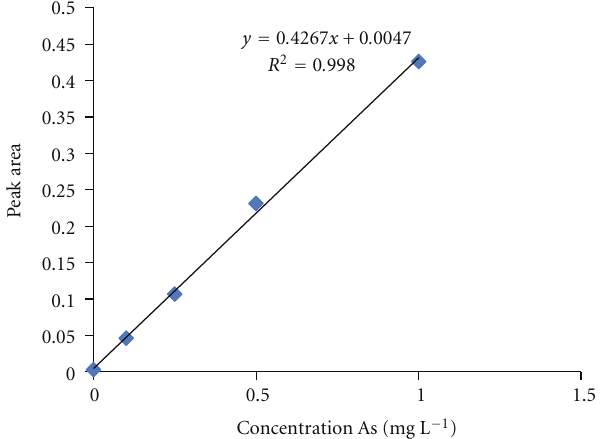
Figure 2: Calibration for liquid sample determination by GFAAS.